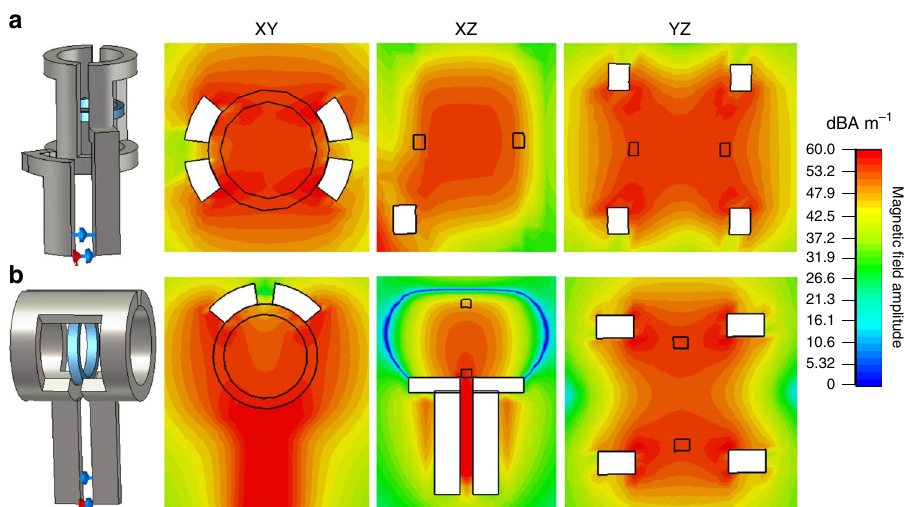
Fig. 3 RF magnetic fi eld simulations of saddle and modi fi ed Alderman-Grant coils. Simulations of saddle ( a ) and modi fi ed Alderman-Grant ( b ) coils were both performed at a frequency of 500